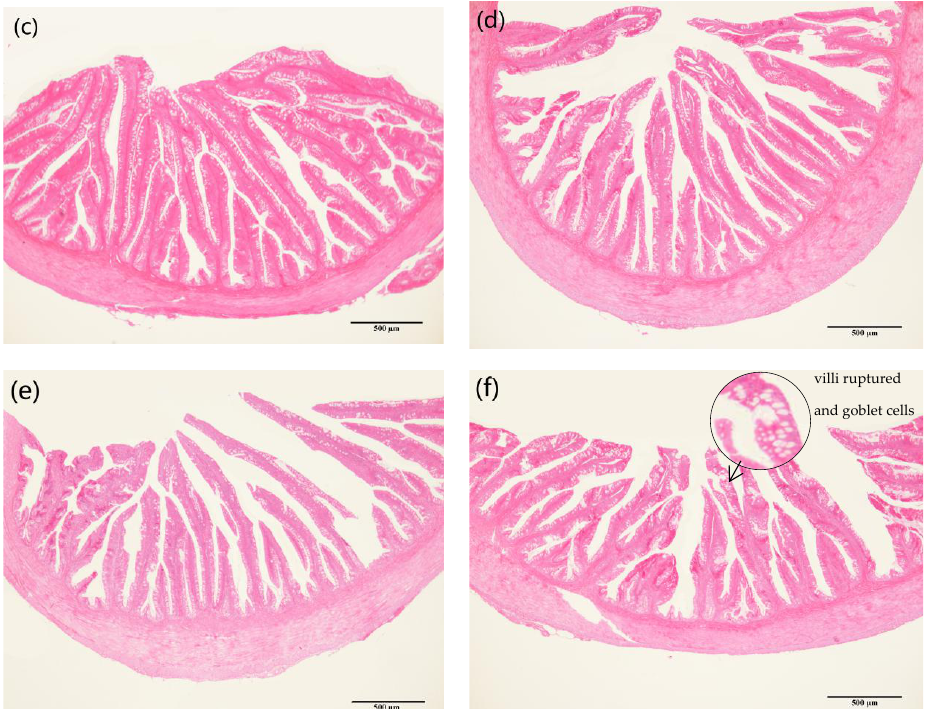
Figure 3. The foregut tissue structure of largemouth bass (40 × ). ( a ) Foregut tissue of control group; ( b ) foregut tissue of CAP-15 group; ( c ) foregut tissue of CAP-30 group; ( d ) foregut tissue of CAP-45 group; ( e ) foregut tissue of CAP-70 group; ( f ) foregut tissue of CAP-100 group. Note: The scale bar in the figure is the magnification contrast of micrograph.